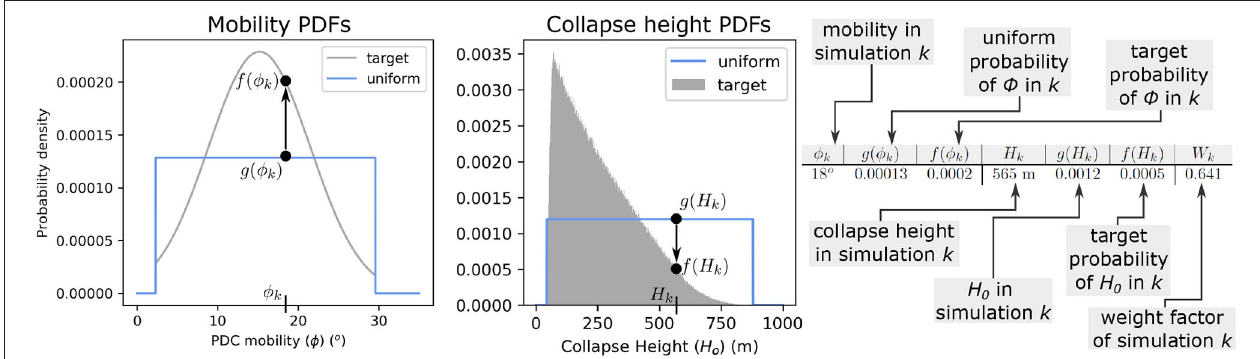
FIGURE 8 | Graphical explanation of the methodology to calculate the weight factor ( W ) for simulation k . The values for the probability of the collapse height ( H o ), and PDC mobility ( φ ), from the target ( f ) and uniform ( g ) probability density functions (PDFs) are evaluated at the value of φ and H o used in simulation k . W k can then be calculated by Equation (5). In this example, W k 0.641, meaning that grid cells in the output of this simulation will be multiplied by 0.641, lowering their relative = importance.